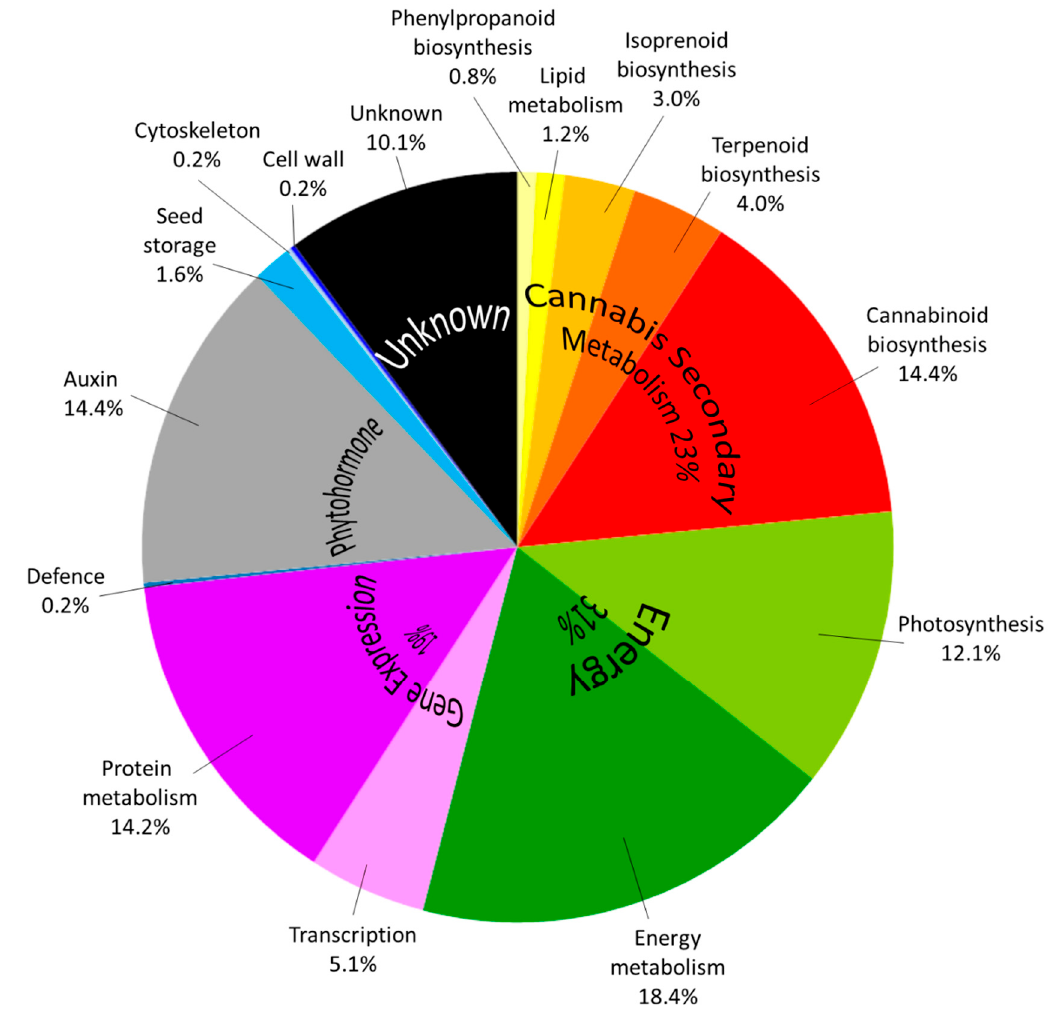
Figure 5. Pie chart of the pathways in which identified Cannabis proteins are involved.